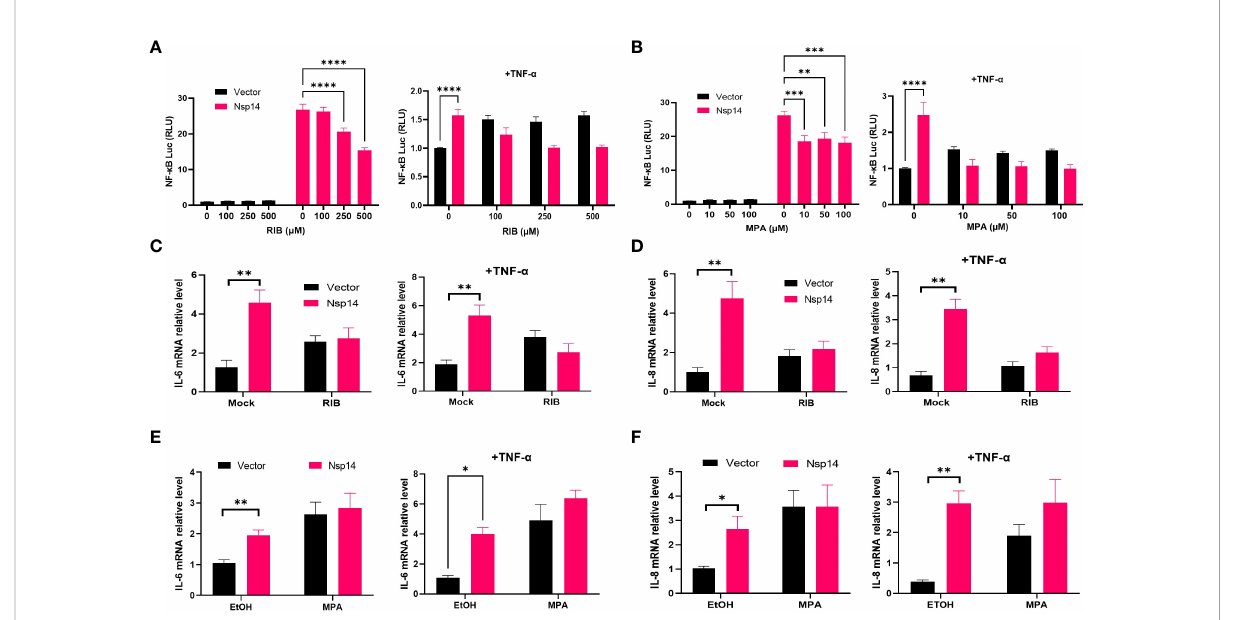
FIGURE 6 IMPDH2 inhibition reduces Nsp14-mediated NF- k B activation and IL8 induction. (A) HEK293T cells transfected with V5-FLAG-Nsp14 or empty vector along with NF- k B-driven fi re fl y luciferase and TK-driven renilla luciferase reporter vectors were treated with ribavirin (RIB) at 24h post of transfection for 24h without or with TNF a stimulation. Luciferase activity ( fi re fl y/renilla) in these cells was measured and normalized to that of un-treated, empty vector-transfected cells. (B) Mycophenolic acid (MPA) was tested similarly as in (A) . Results were calculated from at least 2 independent experiments and presented as mean +/- standard error of the mean (SEM). (** p< 0.01; *** p< 0.001; **** p< 0.0001 by two-way ANOVA and Tukey ’ s multiple comparison test). (C, D) HEK293T cells transfected with V5-FLAG-Nsp14 or empty vector were treated with 500 µM RIB at the basal or TNF- a -stimulated condition. Total RNAs were extracted. IL-6 (C) and IL-8 (D) mRNA was analyzed and normalized to the mock treatment of the empty vector-transfected group. (E, F) 100 µM MPA was tested similarly as in (C, D) , and results were normalized to the solvent control (0.1% ethanol, EtOH) of the empty vector-transfected group. Results were calculated from 3 independent experiments and presented as mean +/- standard error of the mean (SEM). (* p<0.05; ** p<0.01; by unpaired Student ’ s